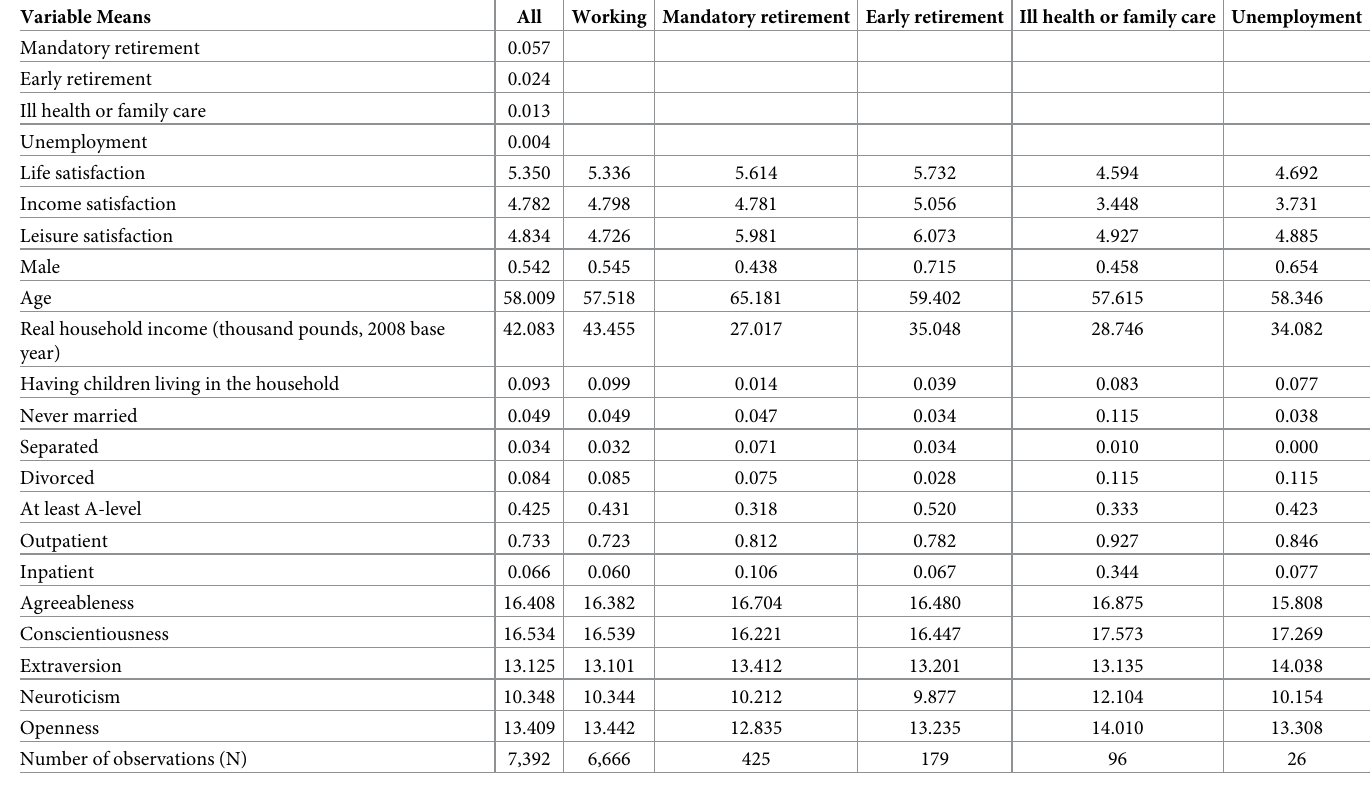
Table 1. Summary statistics (non-standardized) by exit pathway from the labor